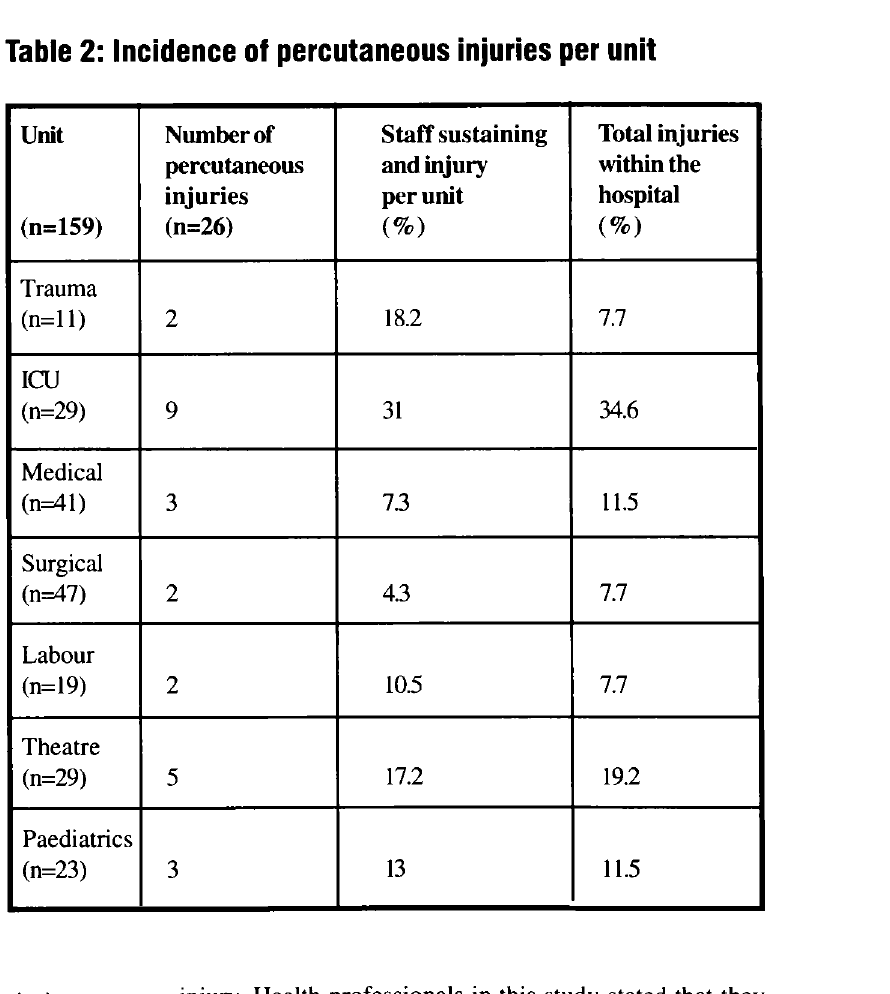
Table 2: Incidence of percutaneous injuries per unit